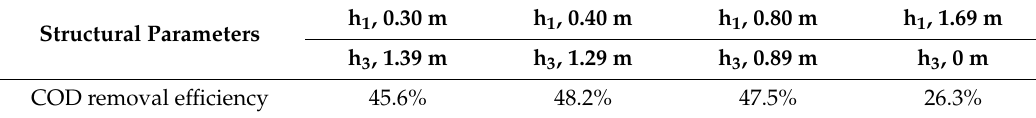
Table 4. E ff ect of structural parameters on the reactor